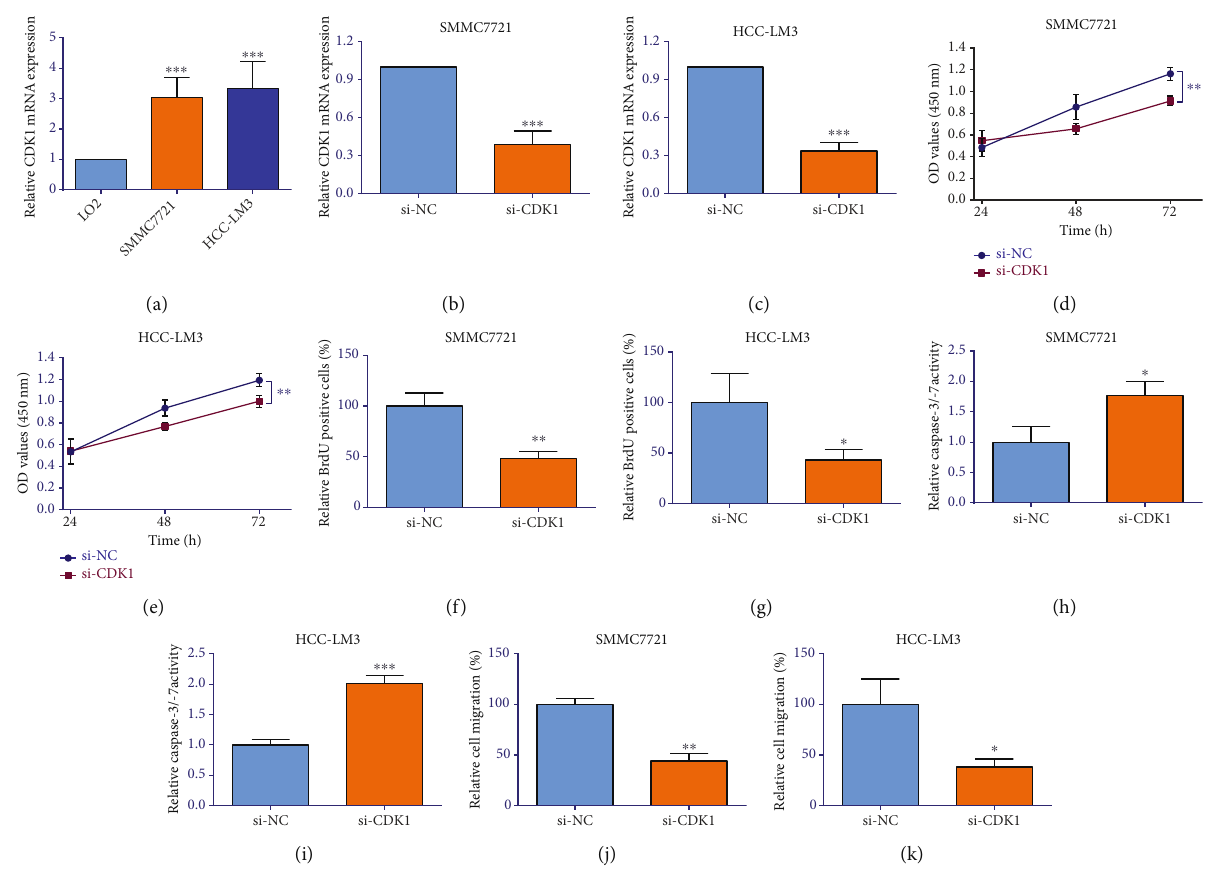
Figure 9: CDK1 silence attenuated HCC cell proliferation and migration. (a) CDK1 expression in the LO2, SMMC7721, and HCC-LM3 cells. (b) – (k) SMMC7721 and HCC-LM3 cells were transfected with si-CDK1 or si-NC, (b) and (c) the CDK1 mRNA expression in SMMC7721 and HCC-LM3 cells; (d) and (e) cell viability of SMMC7721 and HCC-LM3 cells; (f) and (g) cell proliferation of SMMC7721 and HCC-LM3 cells; (h) and (i) caspase-3/-7 activities of SMMC7721 and HCC-LM3 cells; (j) and (k) the cell migration of SMMC7721 and HCC-LM3 cells. N = 3 ; * P < 0 : 05 , ** P < 0 : 01 , and *** P < 0 : 001